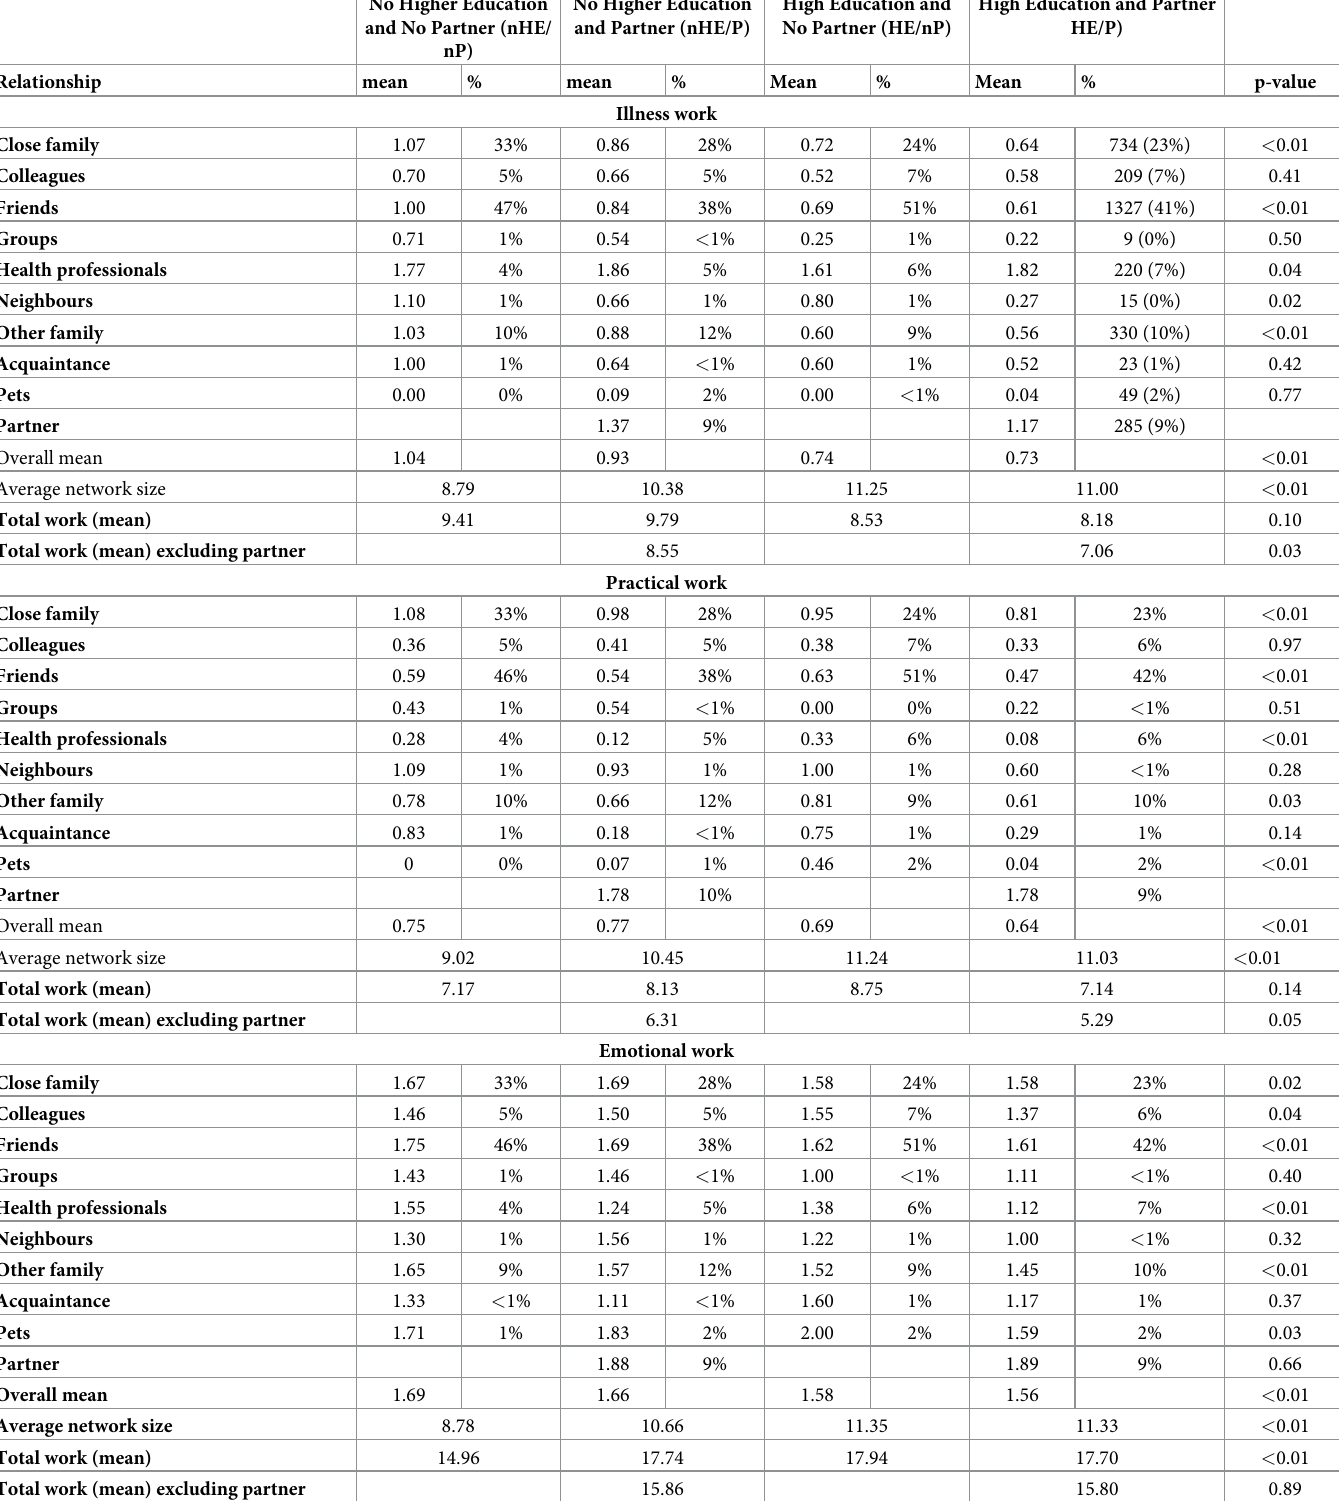
Table 5. Work done by relationship type for women with or without higher education and with or without a partner.